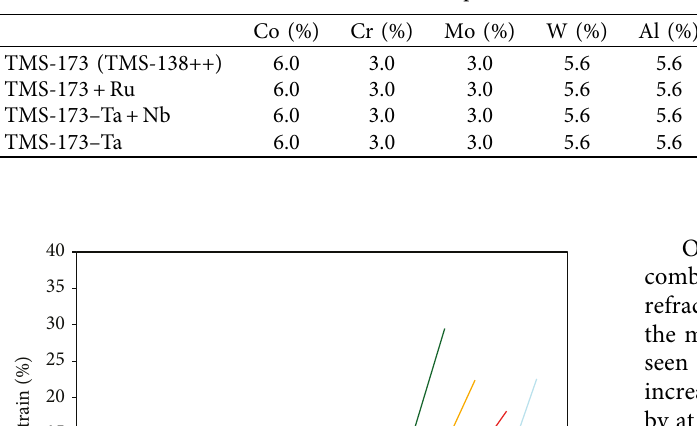
Table 2: Elemental compositions (in wt%) of the various alloy mixtures used [22].